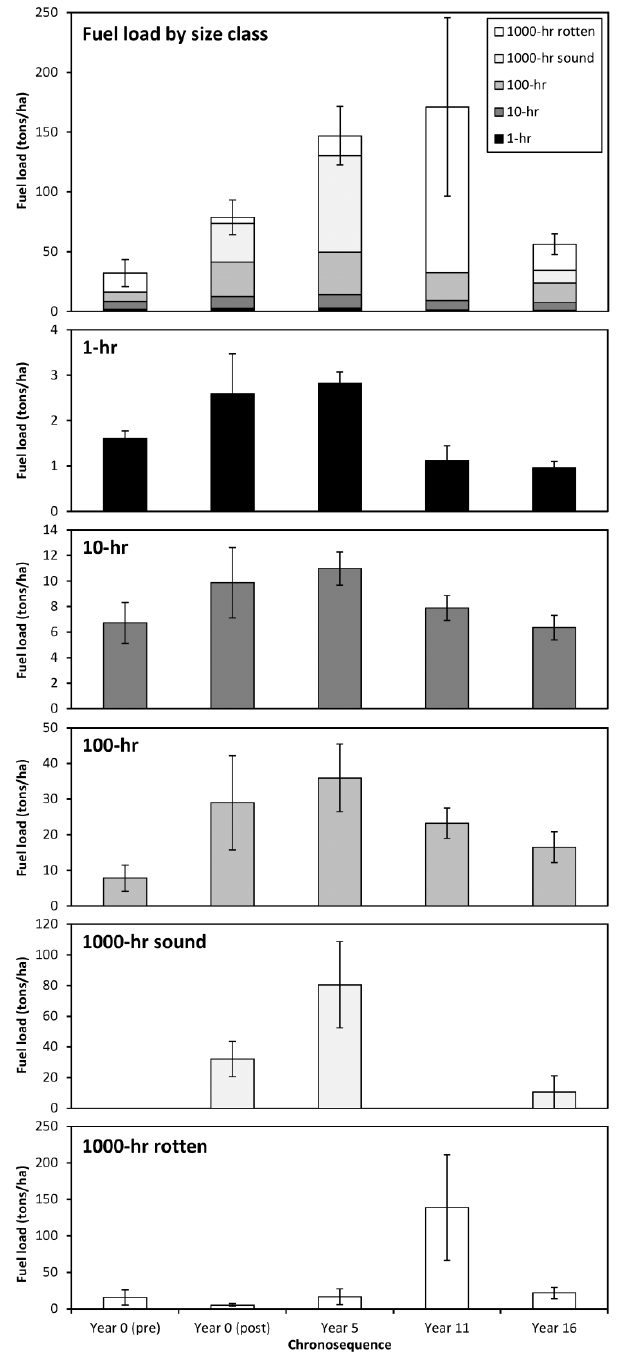
Figure 5. Average fuel loading for all size classes combined, and separated by fuel size class, showing means and standard errors for each stage in chronosequence: pre-treatment and post-treatment year 0 (partial harvest and frill treatment) at Lupton Creek, and year 5, 11, and 16 after frill treatment rehabilitation treatments (no harvest) at Little Pine